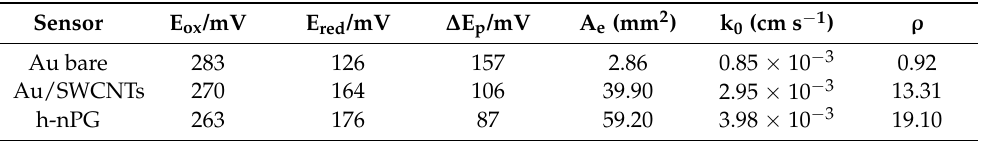
Table 1. Comparison of electroanalytical parameters before and after Au electrode modifications. A g Au bare = 3.10 mm 2